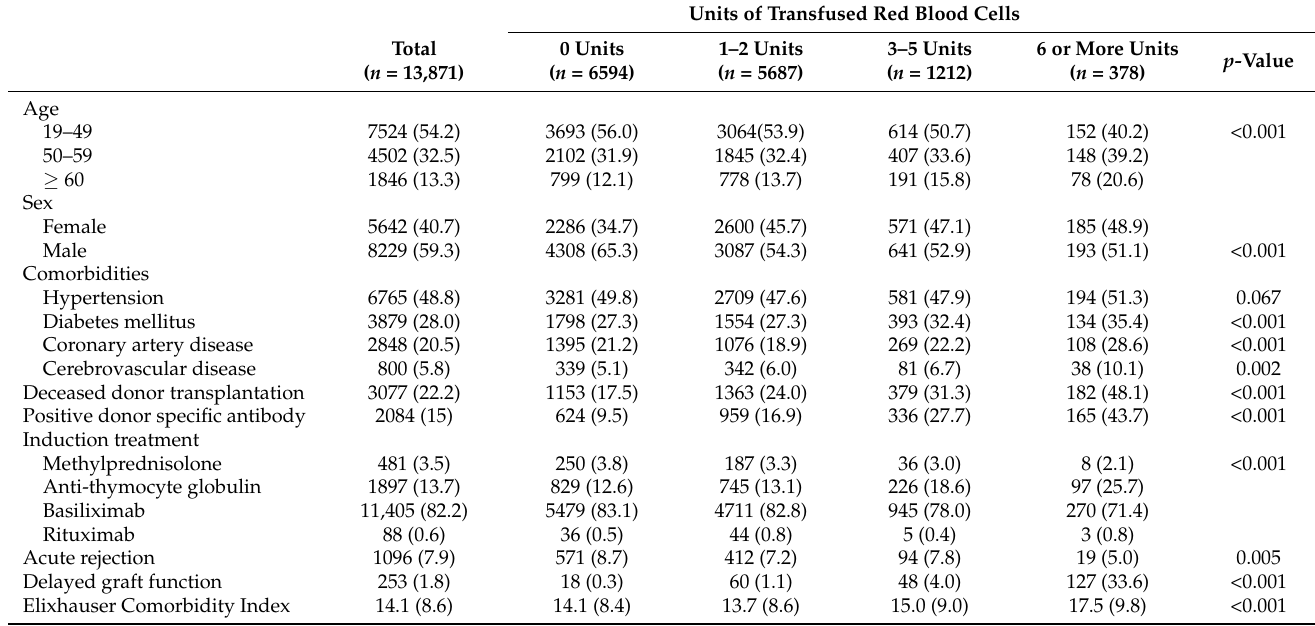
Table 1. Patient characteristics according to the amount of RBC transfusion.